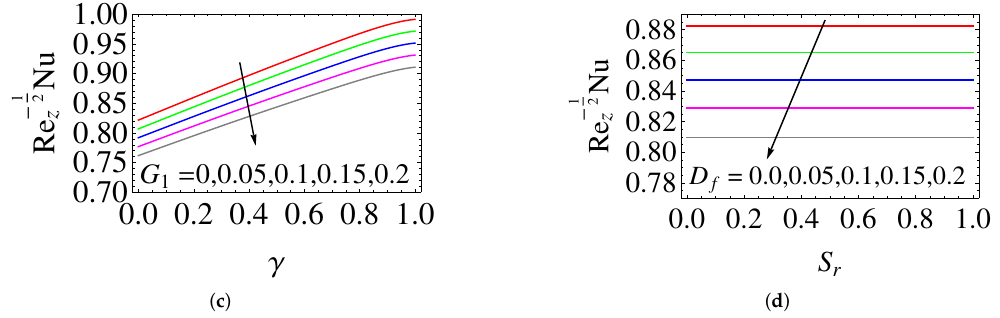
Figure 10. Influences of ( a ) thermal radiation ( Rd ) , ( b , d ) Dufour number ( D f ) and ( c ) thermal stratification ( G 1 ) parameters on Nusselt number.